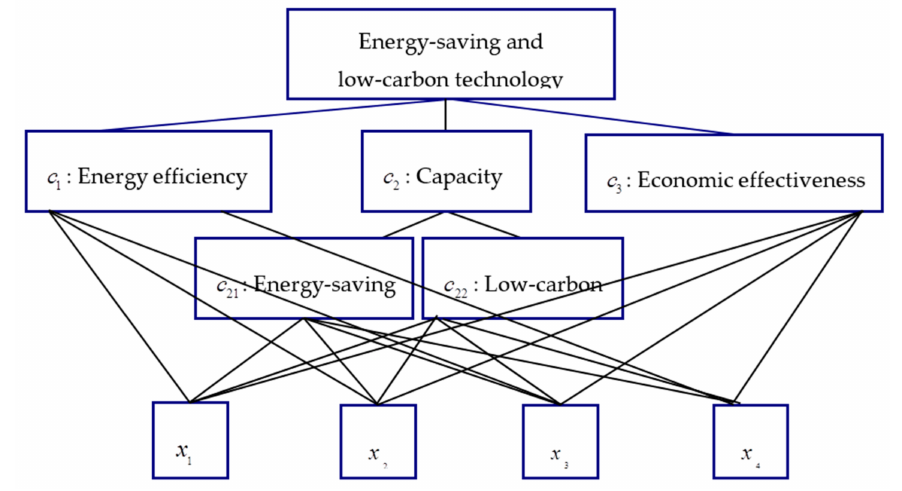
Figure 1. Decision Hierarchical structure.